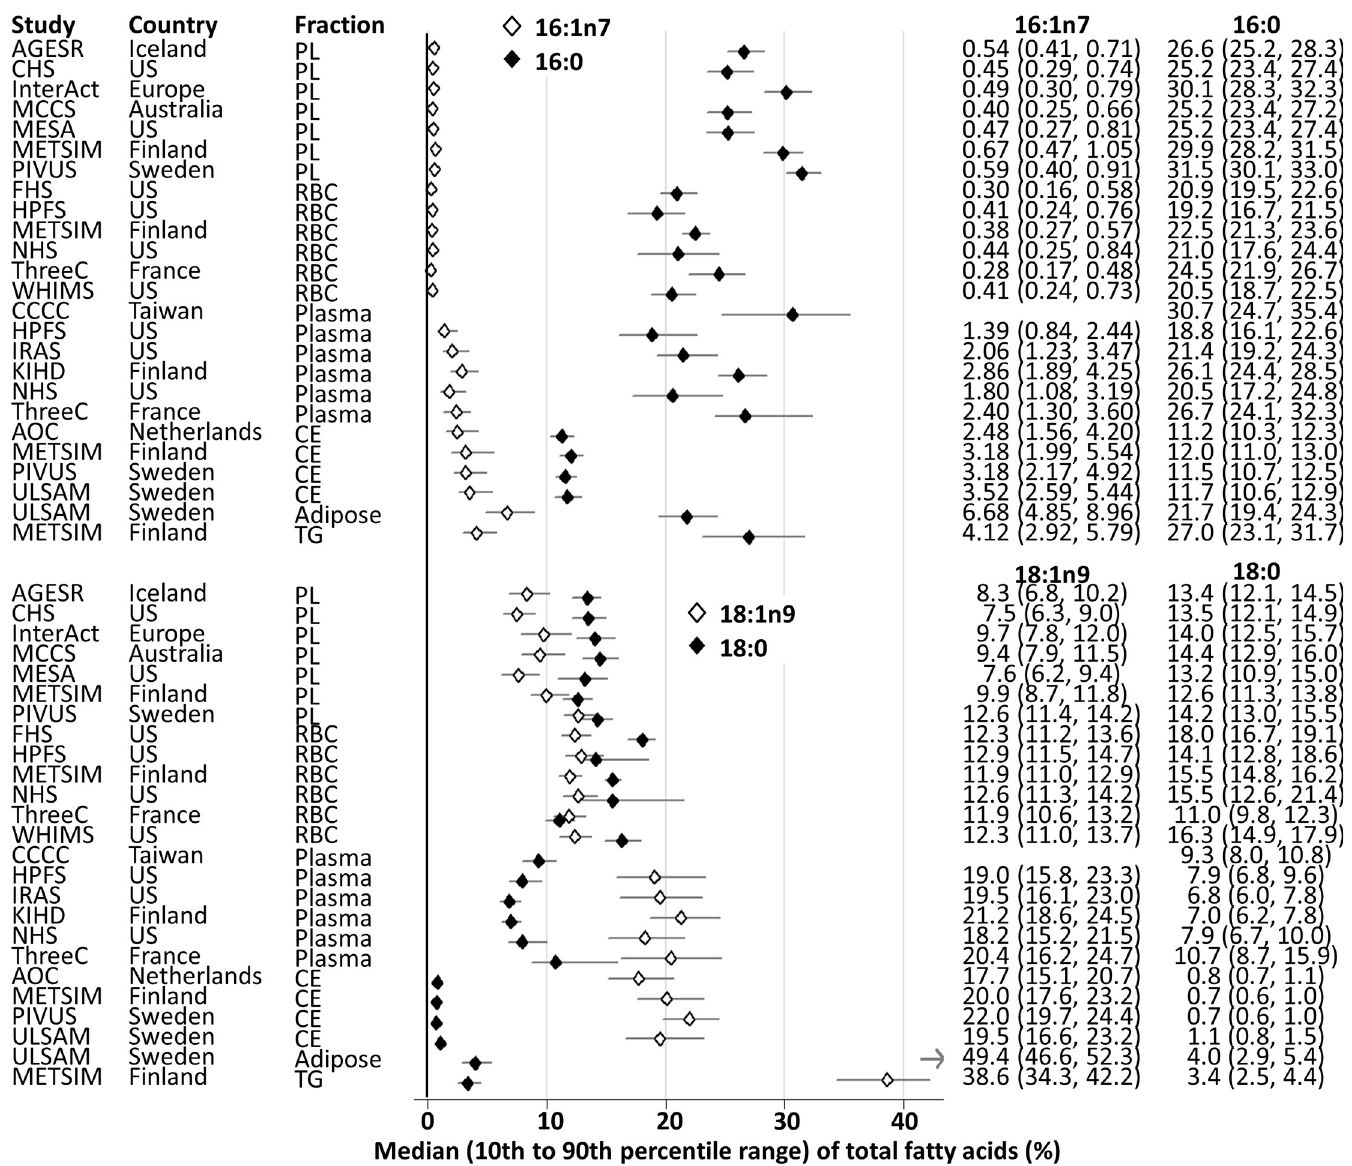
Fig 1. Proportions of fatty acids in the DNL pathway. Plots represent median (diamond) and the range of 10th to 90th percentiles (horizontal bar). See Table 1 for cohort names. CE, cholesteryl ester; DNL, de novo lipogenesis; PL, phospholipid; RBC, red blood cell; US, United States. Further adjusting for triglycerides, the association of 16:0 was modestly attenuated, with RR (95% CI) of 1.36 (1.24–1.50; p < 0.001; S2 Fig). After adjustment for triglycerides and 16:0, associations of 16:1n7 and 18:0 with T2D incidence were attenuated but still evident with RRs (95% CI) of 1.17 (1.11–1.24; p < 0.001) and 1.16 (1.06–1.27; p = 0.001), respectively, whereas the association of 18:1n9 with T2D risk was attenuated to the null (RR = 1.03, 95% CI 0.94– 1.13, p = 0.40). Findings were similar when each fatty acid was evaluated categorically (Fig 3). Heterogeneity was seen in these pooled analyses, with I 2 ranging from 52.1% to 73.1% (Fig (S2 Table, S3–S6 Figs for 16:0, 16:1n7, 18:0, and 18:1n9, respectively). Among post hoc meta-